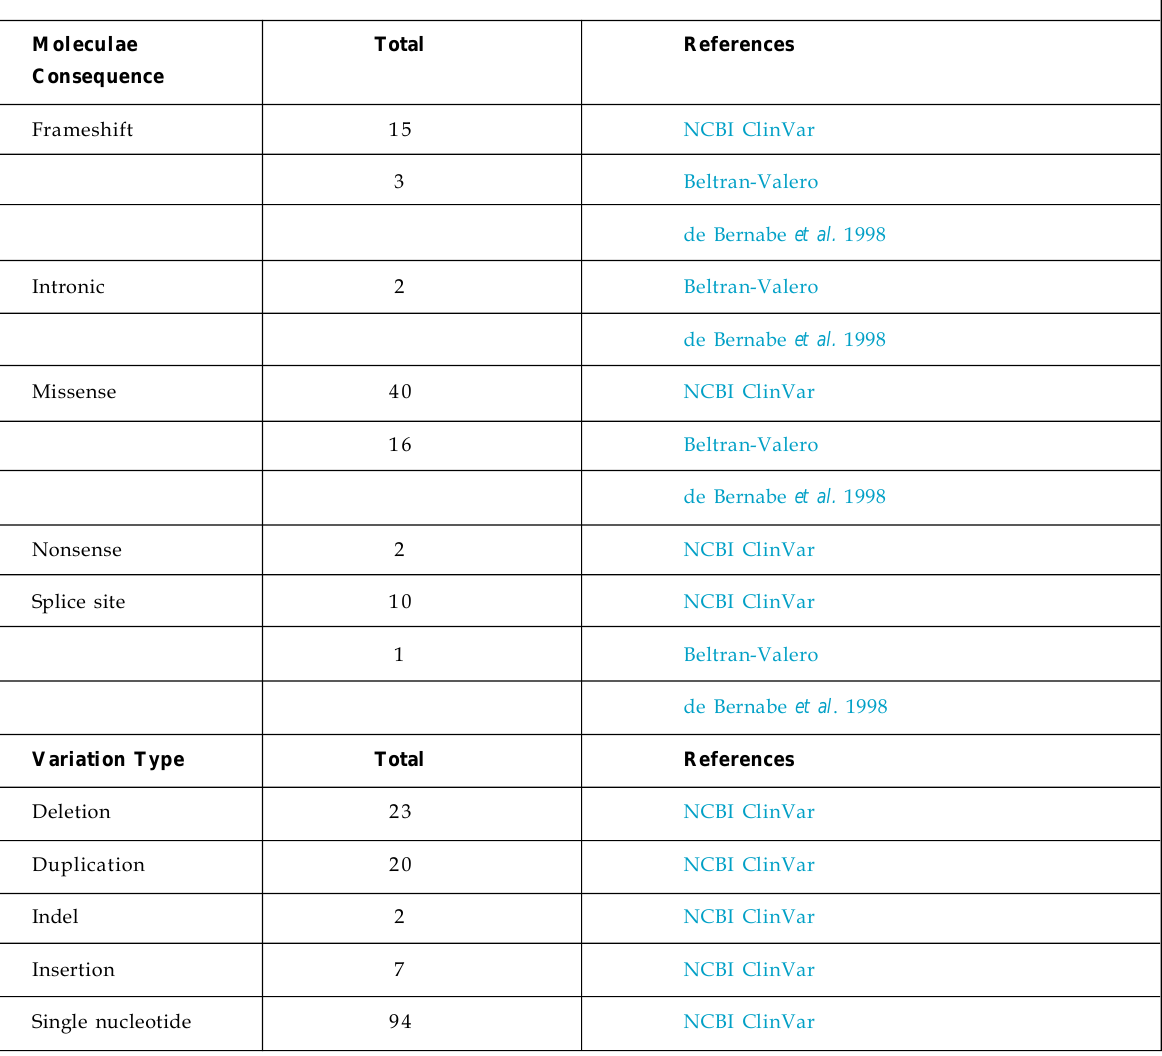
Table 1: Mutations in the HGD Gene Moleculae